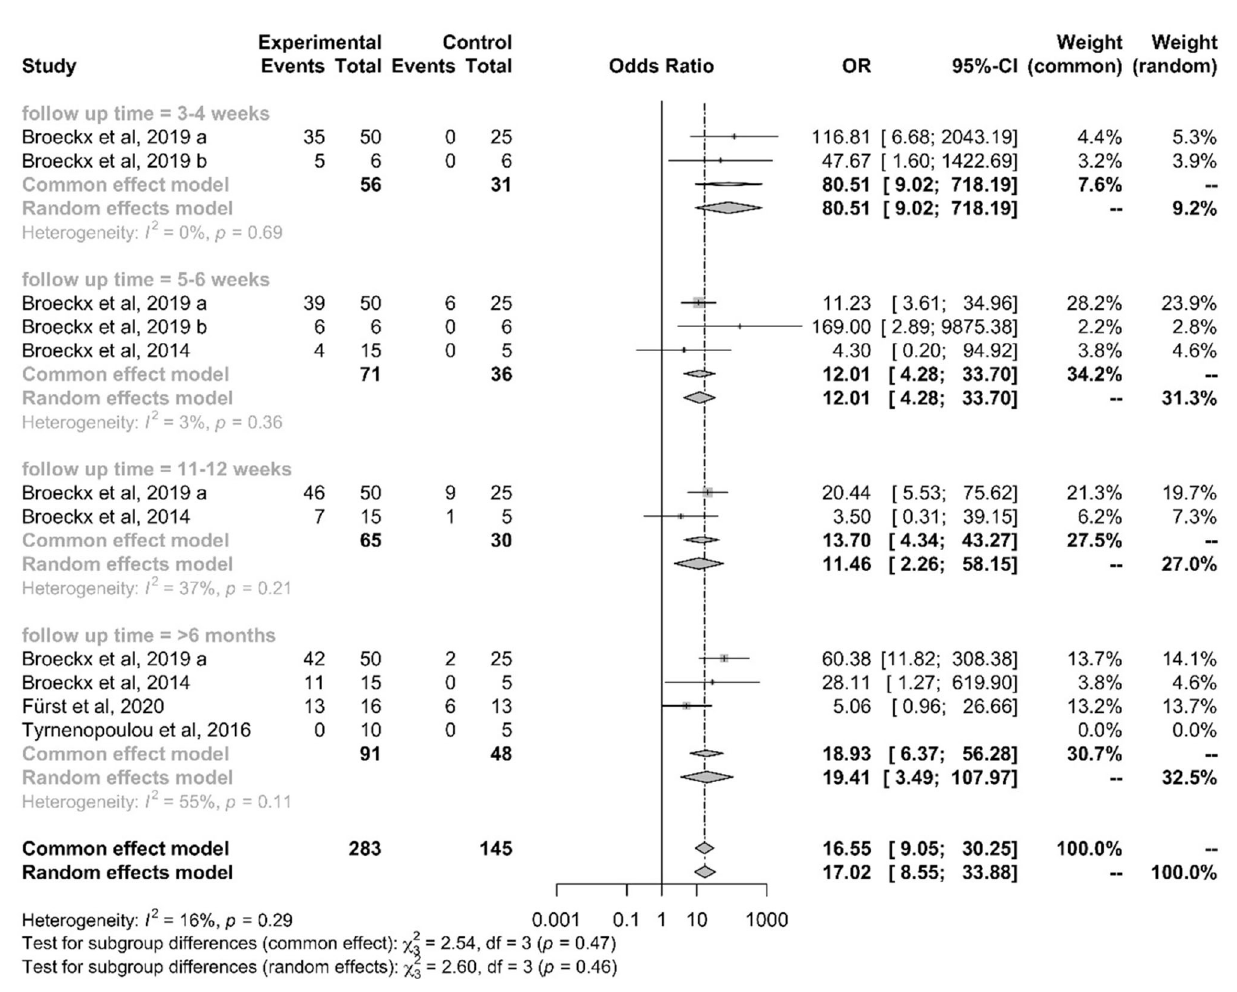
FIGURE6 Forest plot showing results of selected studies using a meta-analysis to compare lameness reduction of experimental and control. The common effect model and the random effects model are shown. Depending on heterogeneity (I 2 > 50%) the random effects model was used for studies with long-term follow-up. The greater the squares, the more participants included the study. The size of the squares is proportional to the weight of the study. The whiskers correspond to the 95% confidence interval